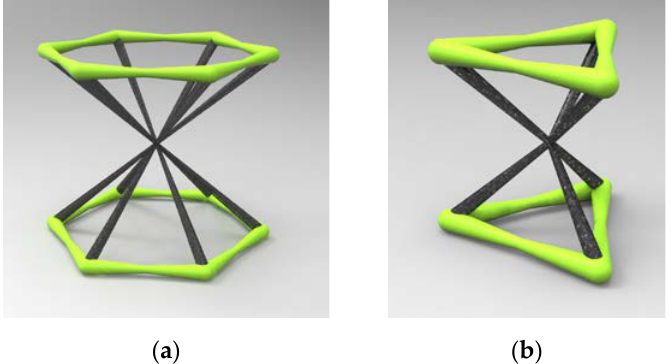
Figure 2. Schematic illustration of the bi-material single-layer hourglass unit cell: ( a ) hexagon type; ( b ) triangle type. ( b ) triangle type. Table 1. Mechanical and thermal properties of the materials.